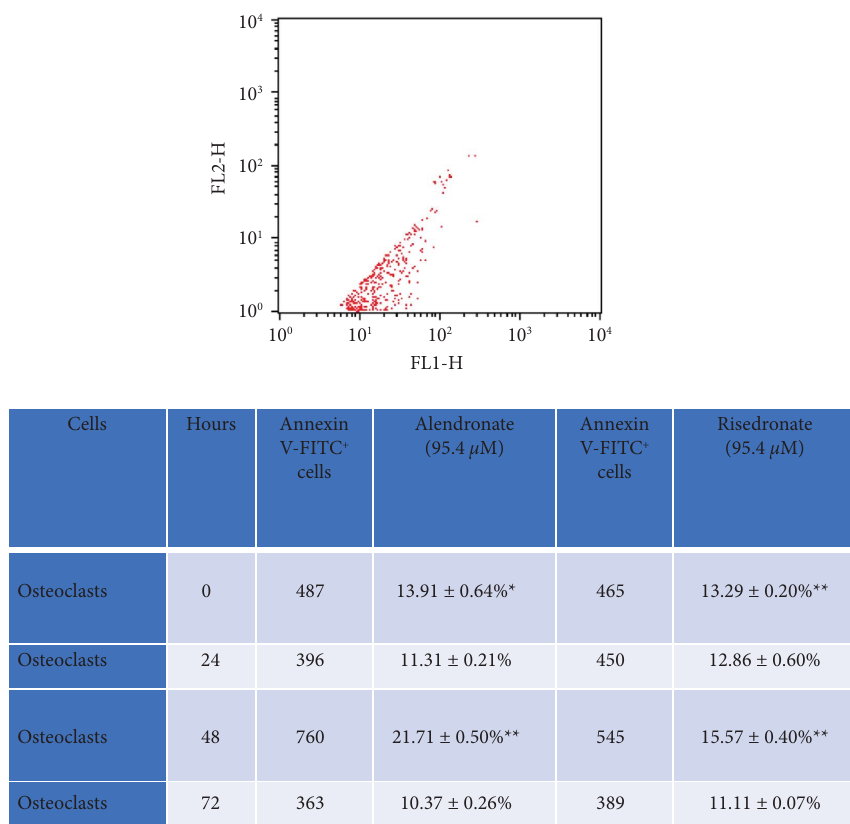
Figure 5: Comparison of Annexin V expression in cultured osteoclasts stimulated in vitro with alendronate (95.4 mM) or risedronate (95.4 mM) with that in control cells. Signifcant upregulation of Annexin V at 0 and 48h with alendronate ∗∗ and at 0 and 48h with risedronate; ∗ P < 0 . 05 and ∗∗ P < 0 .